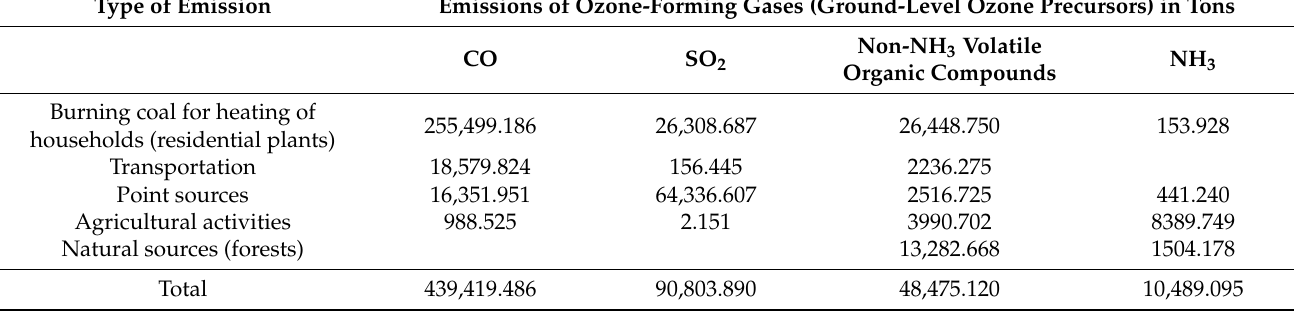
Table 6. Emission of ozone precursors in Silesian Voivodship in 2015 based on the Silesian Regional Assembly 2016 [47]. Type of